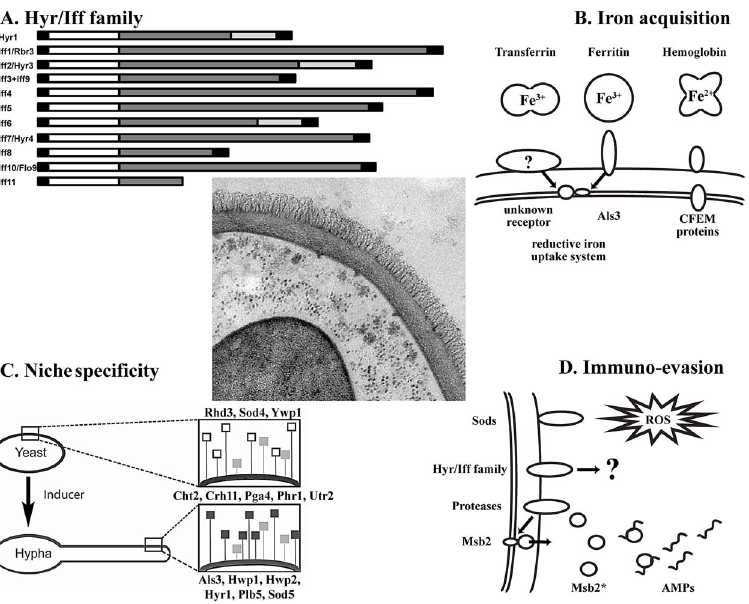
Figure 1. Key concepts of the C.albicans wall proteome. Center: TEM picture of the cell wall and its proteins (courtesy of Iuliana V. Ene and Alistair J.P. Brown, Aberdeen). (A) Domain structure of the Hyr/Iff family (adapted from [7]). From left to right: N-terminal signal peptide; white box, conserved domain; dark grey box, Ser/Thr-rich region; light grey box, Asp/Gly-rich region; black box, GPI-anchor addition signal. (B) Wall proteins implicated in iron acquisition from host proteins. Membrane and wall-bound CFEM proteins are able to bind hemoglobin, while Als3 is the receptor for ferritin. It is unknown if there exists a receptor for transferrin. Bound hemoglobin is taken up by endocytosis, while iron from ferritin and transferrin is sequestered via the reductive iron uptake system. (C) Effect of yeast-to-hypha transition on the wall proteome with yeast-associated (top; open squares), morphotype-independent (middle; grey squares) and hypha-associated (bottom; black squares) proteins [2]. (D) Interaction of wall proteins with the immune system. Wall-resident superoxide dismutases (Sods) detoxify reactive oxygen species (ROS) to H 2 O 2 , which is subsequently converted into H 2 O and O 2 by catalase activity [20]. Proteins of the Hyr/Iff family confer resistance to neutrophil and phagocyte killing through an unknown mechanism [12]. Possibly, like in S. cerevisiae , proteases situated on the cell wall process the trans-membrane signaling protein Msb2 and liberate the extracellular domain Msb2*. Msb2* is able to bind to antimicrobial peptides (AMPs) in a dose-dependent manner and confers resistance